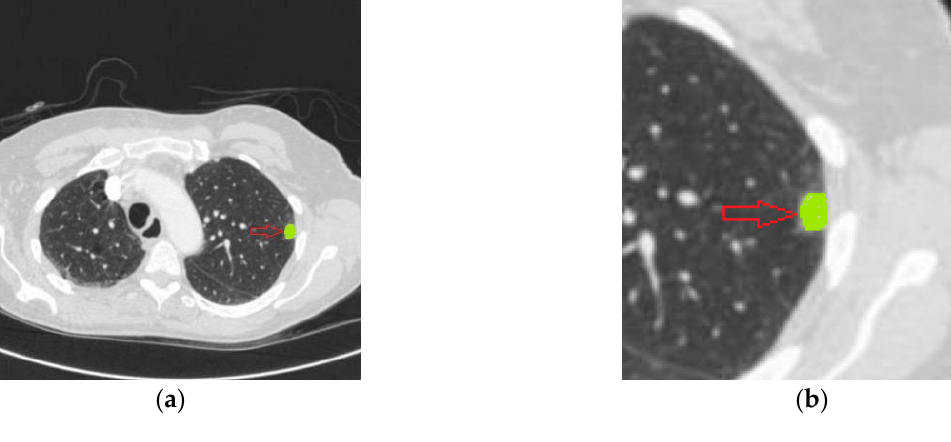
Figure 6. Lung CT image [13]: ( a ) Original image with nodule (green color), ( b ) the part of CT image with nodule > 3 mm ROI (green color). Note that the xml file includes the outline of the node (only its boundary points). In this case, the entire nodule is displayed for better understanding and visibility.